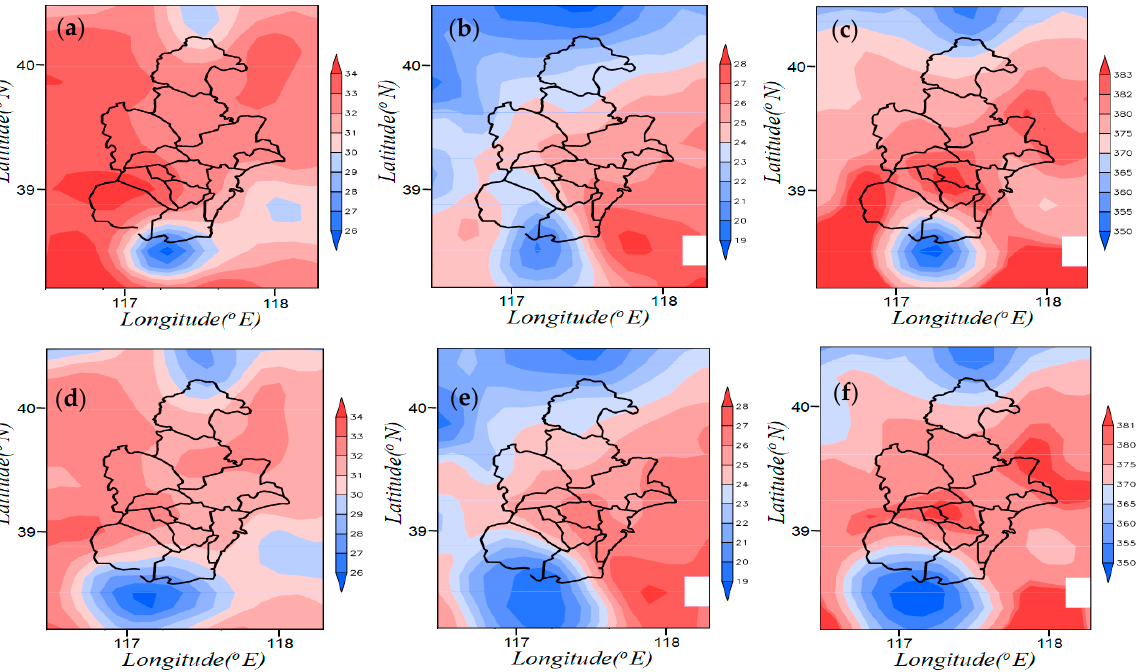
Figure 7. Distribution of surface temperature (colored, unit: ° C): ( a ) 17:00 BT and ( d ) 18:00 BT. Distribution of surface dew point temperature (colored, unit: ° C): ( b ) 17:00 BT and ( e ) 18:00 BT. Distribution of surface pseudo-equivalent potential temperature (colored, unit: K): ( c ) 17:00 BT and ( f ) 18:00 BT .